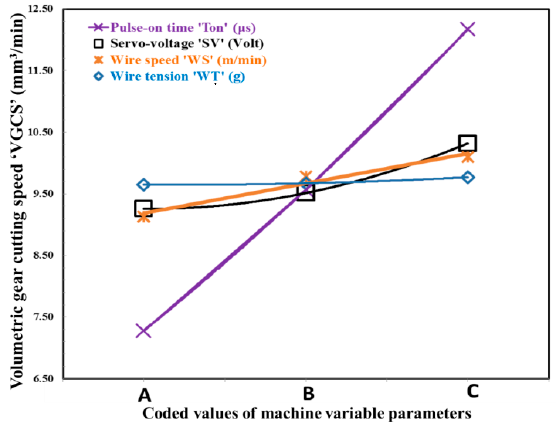
Figure 5. Coded values of machine variable parameters and their effect on volumetric gear cutting